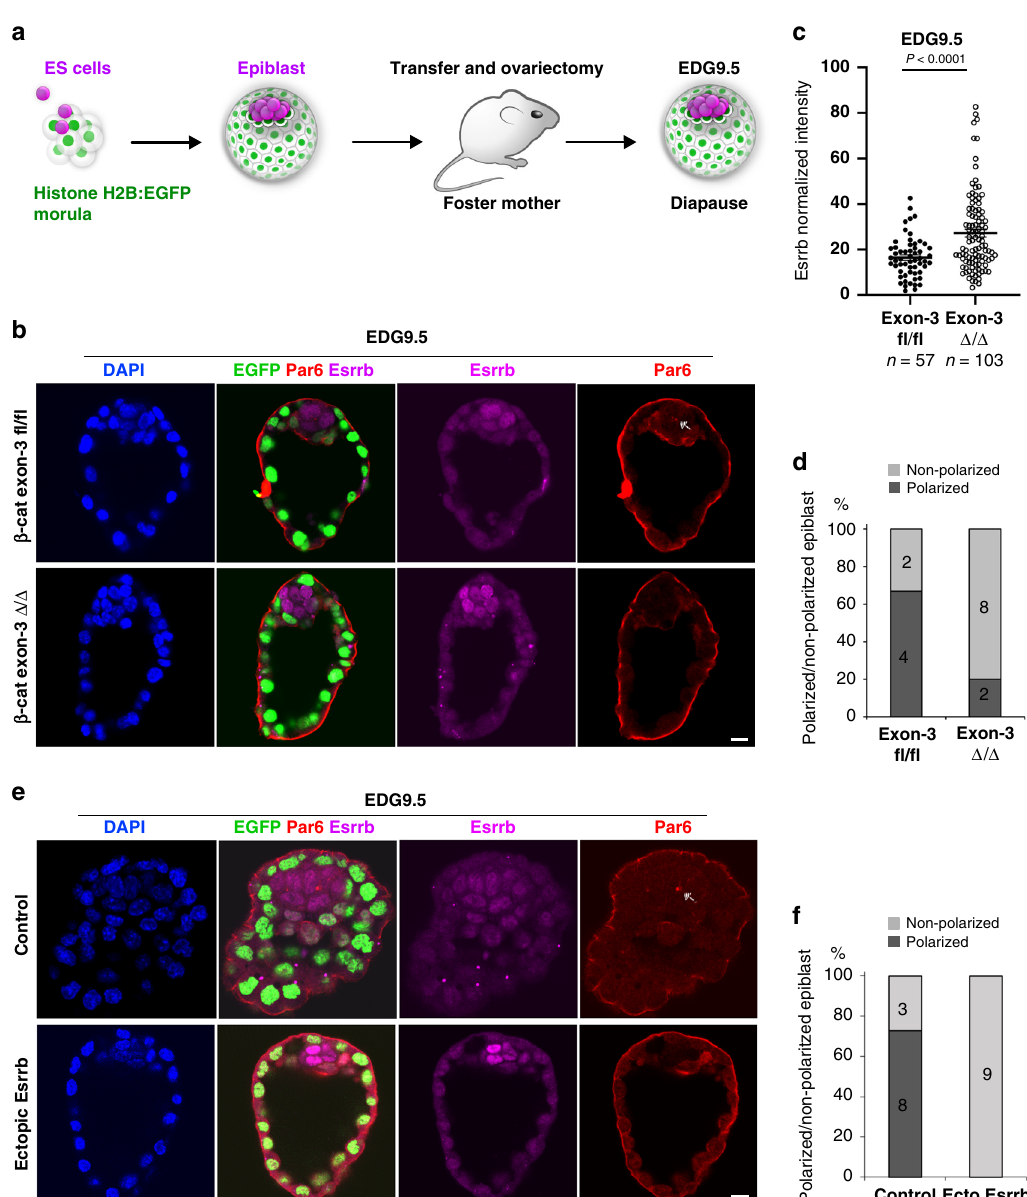
Fig. 7 Wnt/ β -catenin/Esrrb cascade controls the tissue-scale organisation of the epiblast during diapause. a Schematic representation of the generation of chimeric blastocysts. b EDG9.5 chimeric embryos containing epiblast comprised of β -catenin exon-3 Δ / Δ or control β -catenin exon-3 fl / fl cells stained for Esrrb, EGFP, Par6 and DAPI. c Esrrb expression in β -catenin exon-3 Δ / Δ or control β -catenin exon-3 fl / fl epiblast cells at EDG9.5. Data represent mean ± SEM, n = cells measured in ten β -catenin exon-3 Δ / Δ and six control β -catenin exon-3 fl / fl embryos, two-tailed unpaired Student ’ s t test, the exact P value is noted in the fi gure. d Percentage of chimeric embryos with polarised and non-polarised β -catenin exon-3 Δ / Δ or control β -catenin exon-3 fl / fl epiblast. e EDG9.5 chimeric embryos containing epiblast comprised of wild-type (control) or Esrrb ectopically expressing ES cells stained for Esrrb, EGFP, Par6 and DAPI. f Percentage of chimeric embryos – control and ectopically expressing Esrrb, with polarised and non-polarised epiblast at EDG9.5. Scale bars, 10 µ